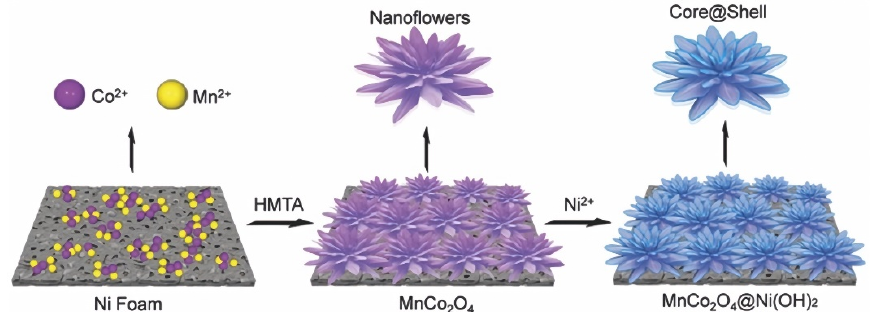
Figure 7. Schematic illustration of the general electrode design process. Reproduced with permission from Limin Wu, Preparation of MnCo 2 O 4 @Ni(OH) 2 Core-Shell Flowers for Asymmetric Supercapacitor Materials with Ultrahigh Specific Capacitance; published by Wiley-VCH Verlag, 2016 [88].